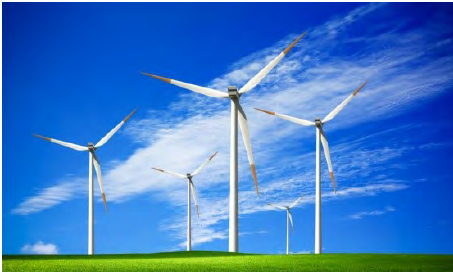
Figure 14. Windfarm